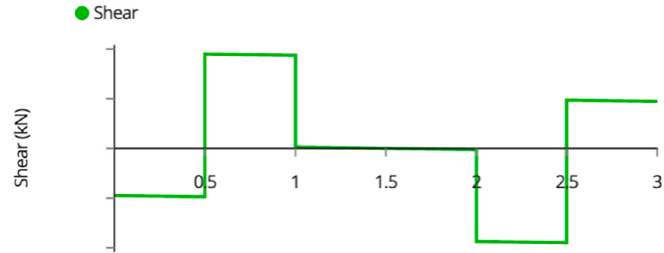
Figure A6. Beam shear force diagram.